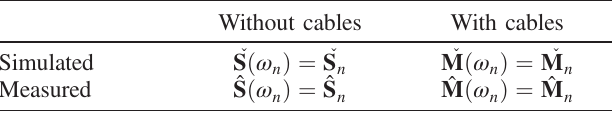
TABLE V. Used nomenclature to handle measured and simulated S-parameters of ACC39 with and without influences of the cables, which connect the module with the HOM board.